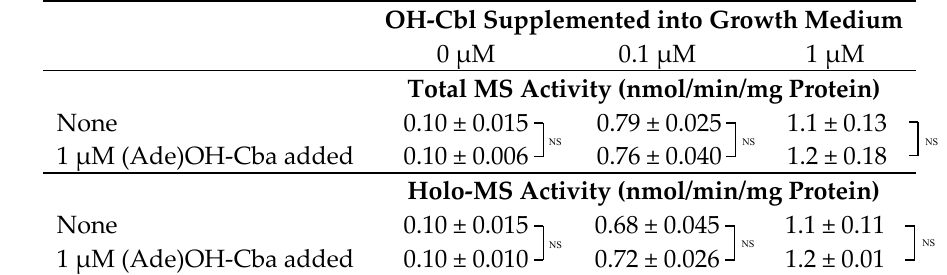
Table 1. Effects of addition of (Ade)OH-Cba on the total and holo-MS activity in cells grown with or without OH-Cbl.